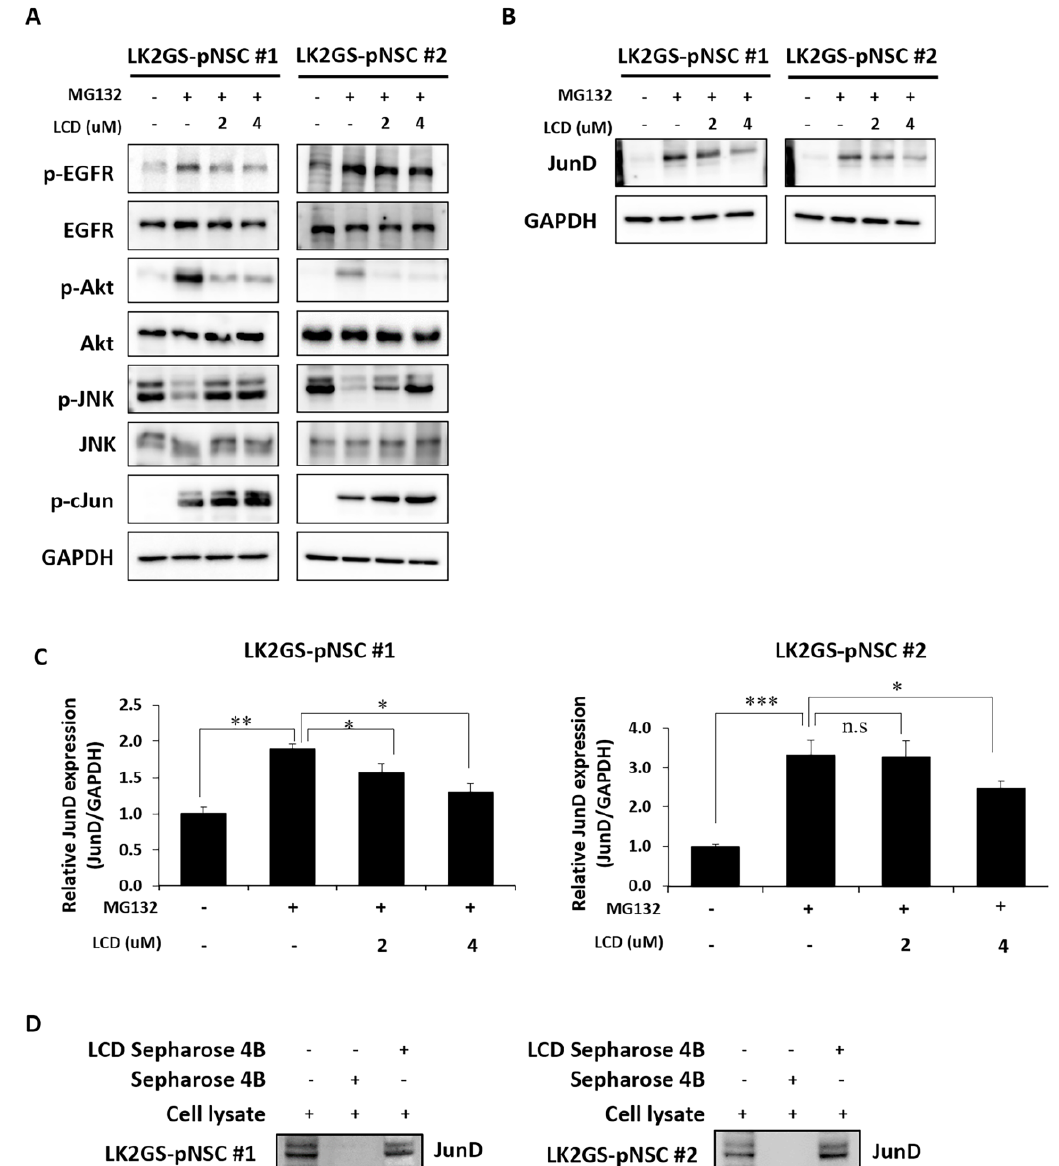
Figure 5. LCD administration regulates the phosphorylation of EGFR/AKT and JNK in MG132- treated with LK2GS-pNSCs. ( A , B ) Western blot analysis was performed with antibodies against p-EGFR, EGFR, p-AKT, AKT, p-JNK, JNK, p-cJun, and JunD. GAPDH was used as an internal standard protein. ( C ) qRT-PCR analyses showing relative expression levels of JunD transcripts. After normalization with GAPDH, results are means ± S.E.M for three independent experiments (* p < 0.05, ** p < 0.01, *** p < 0.001, n.s: no significance). ( D ) LCD binds JunD. Whole LK2GS-pNSCs lysates were incubated with Sepharose 4B or LCD-Sepharose 4B beads for 16 h at 4 ◦ C. Beads were washed, and pulled-down JunD protein was visualized by Western